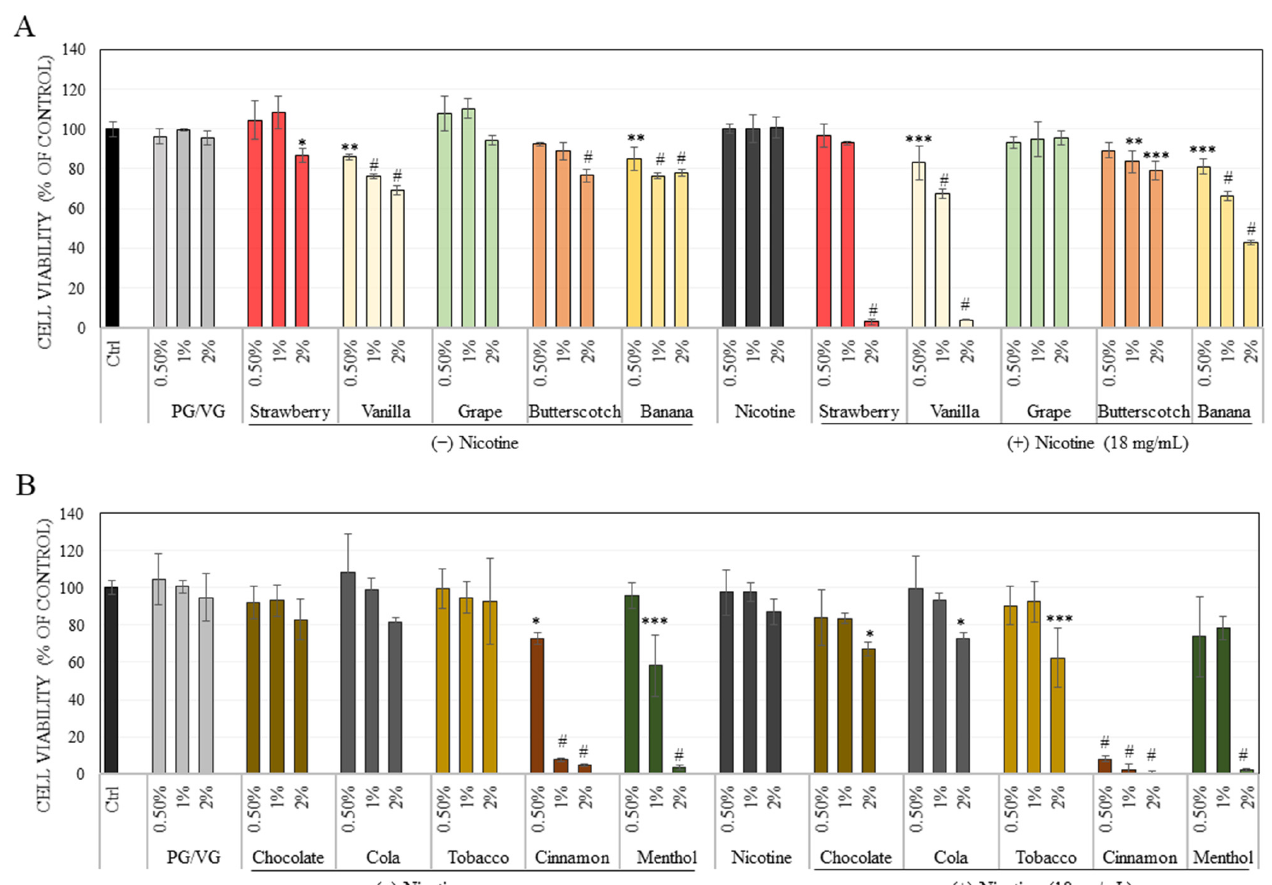
Figure 1. Viability of ARPE-19 cells after treatment with nicotine-free ( − ) and nicotine-rich (+) e-liquids of ( A ) Flavors: strawberry, vanilla, grape, butterscotch, banana, and ( B ) Flavors: chocolate, cola, tobacco, cinnamon, menthol over a duration of 48 h, as measured by Alamar Blue assay. PG/VG represents the vehicle (80/20 v / v ), and Nicotine refers to unflavored base-liquid containing 18 mg/mL nicotine in 75/25 PG/VG., Data are mean ± SD of a representative experiment in triplicates out of three independent experiments, One-way ANOVA with Dunnett’s test. * p < 0.05; ** p < 0.01; *** p < 0.001 and # p < 0.0001 vs. Ctrl.